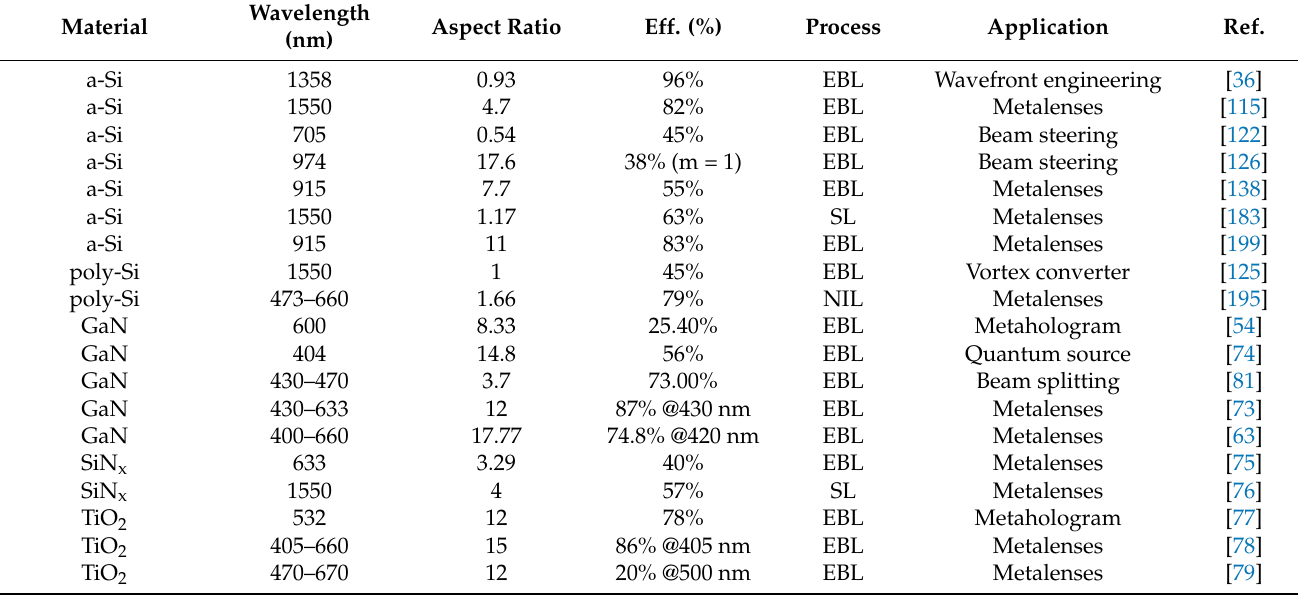
Table 1. Reported performance of dielectric-based